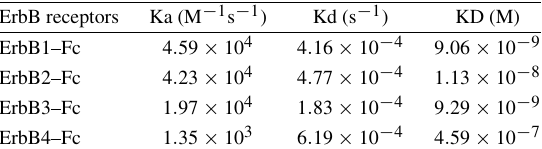
Affinity and rate constants for interaction of Inherbin3 with various ErbB receptors ErbB receptors